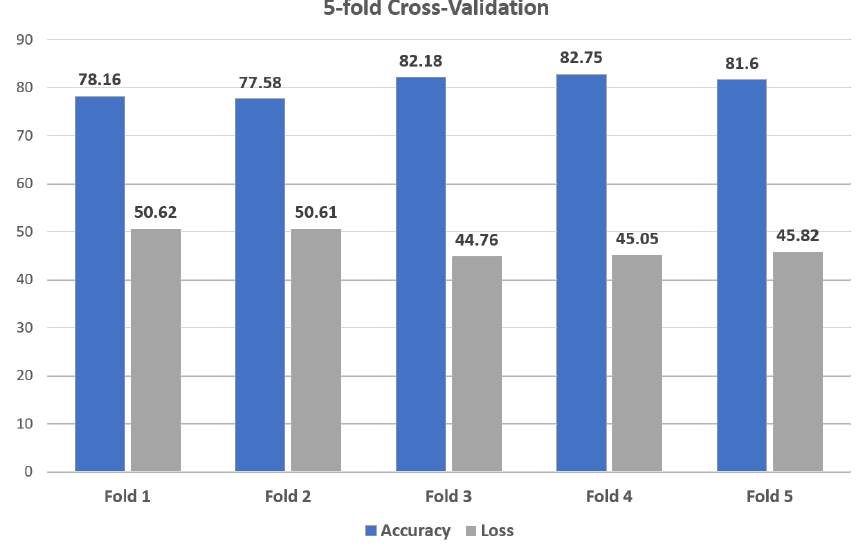
Figure 10. K-Fold Cross-Validation of 12.5-s